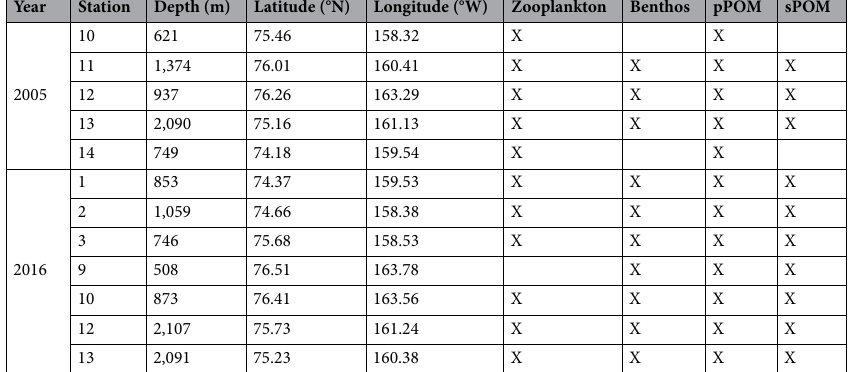
Table 3. Station locations, depth and sample types collected for stable isotope analysis in 2005 and 2016 in the Chukchi Borderland of the Arctic Ocean. pPOM and sPOM is pelagic and sediment particulate organic matter, respectively.